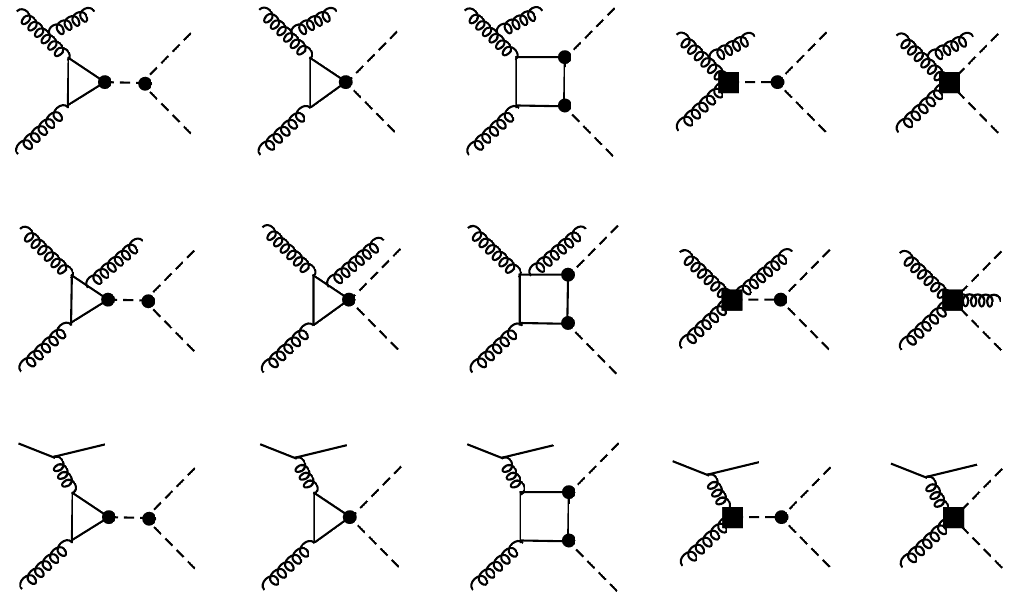
Figure 5. Higgs-pair production in gluon fusion at NLO: examples for real-emission diagrams at order g 3 . s